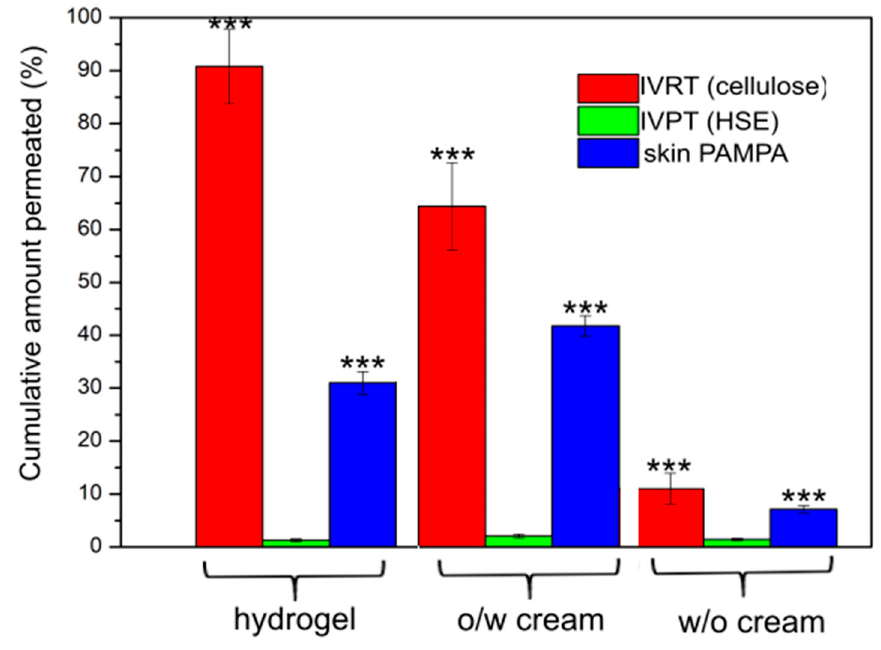
Figure 1. Cumulative amount permeated at the end of 6 h (%). *** p < 0.001 vs. HSE.